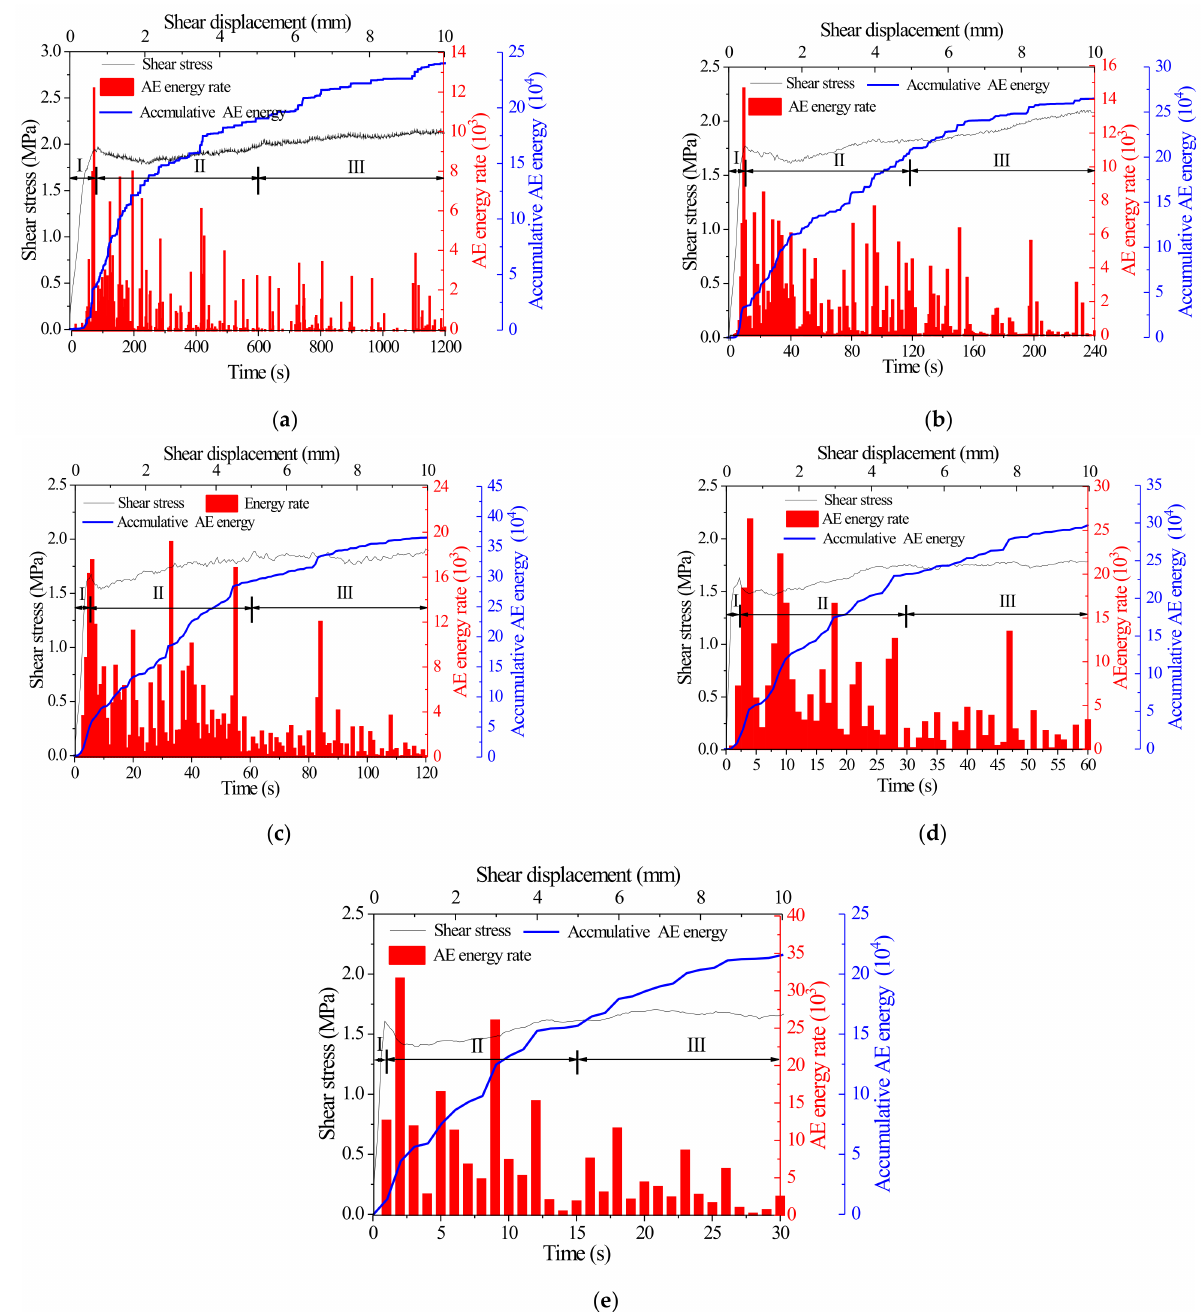
Figure 15. Difference between AE energy rate and cumulative AE energy of joints with diverse shear rates under diverse CNS conditions. ( a ) Shear rate = 0.5 mm/min; ( b ) Shear rate = 2.5 mm/min; ( c ) Shear rate = 5 mm/min; ( d ) Shear rate = 10 mm/min; ( e ) Shear rate = 20 mm/min. The values of the peak AE hit/energy rate, the total number of AE hits/energy,